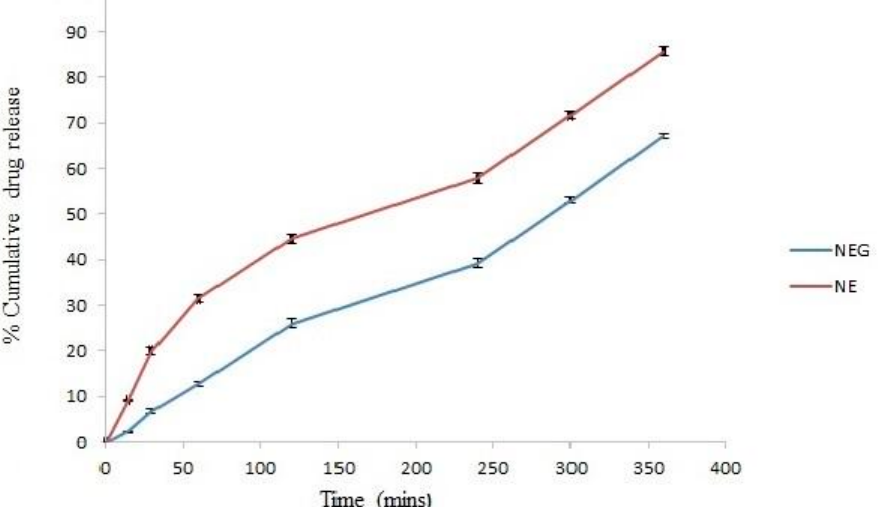
Figure 5. Release profile of minocycline nanoemulsion (NE) and minocycline nanoemulgel (NEG).